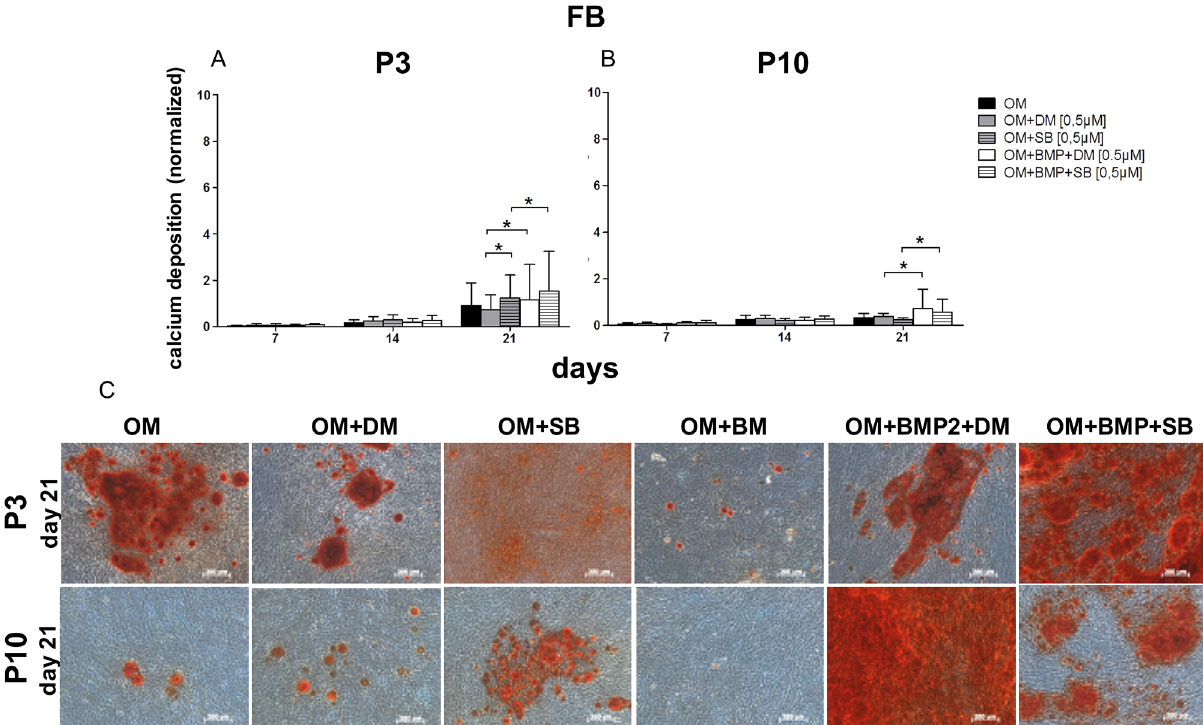
Figure 7. Comparison of the FB osteogenic differentiation potential at P3 versus P10. ( A ) Evaluation of osteogenic differentiation potential at P3 with alizarin red s. The osteogenic differentiation increased over the time course. At day 21 the inhibition of the TGF-β signaling with SB431542 (OM + SB) was significantly superior to the inhibition of BMP signaling with dorsomorphin (OM + DM) and even better than the inhibition of TGF-β signaling with the simultaneous use of BMP-2 (OM + BMP + SB). The differentiation with BMP-2 and simultaneous inhibition of the BMP signaling with dorsomorphin (OM + BMP + DM) was significantly better than the osteogenic differentiation with BMP-2 alone (OM + BMP). ( B ) Evaluation of the osteogenic differentiation potential at P10 with alizarin red s. At day 21 the osteogenic differentiation with BMP-2 with the simultaneous inhibition of the BMP signaling (OM + BMP + DM) was the best and significantly superior to the treatment with dorsomorphin only (OM + DM). Inhibiting the TGF-β signaling with SB431542 and the additional use of BMP-2 (OM + BMP + SB) was significantly superior to the inhibition of TGF-β signaling with SB431542 (OM + SB). Black bars are FB differentiated with osteogenic standard differentiation media (OM). Grey bars are FB differentiated with OM and dorsomorphin (OM + DM). Stacked grey bars were FB differentiated osteogenically and treated with SB431542 (OM + SB). White bars were FB coincubated with OM and BMP-2 with the inhibitor dorsomorphin (OM + BMP + DM). Stacked white bars are FB differentiated with OM, BMP-2 and the inhibitor SB431542 (OM + BMP + SB). Bars represent mean ± SD of three donors. * p < 0.05 as compared to the respective sample of the culture of P10. ( C ) Visualized comparison of osteogenic differentiation potential of DSC at P3 and P10. Evaluation was performed with alizarin red s on day 21. Shown is one representative illustration of at least six identical results. The image scales represent a length of 200